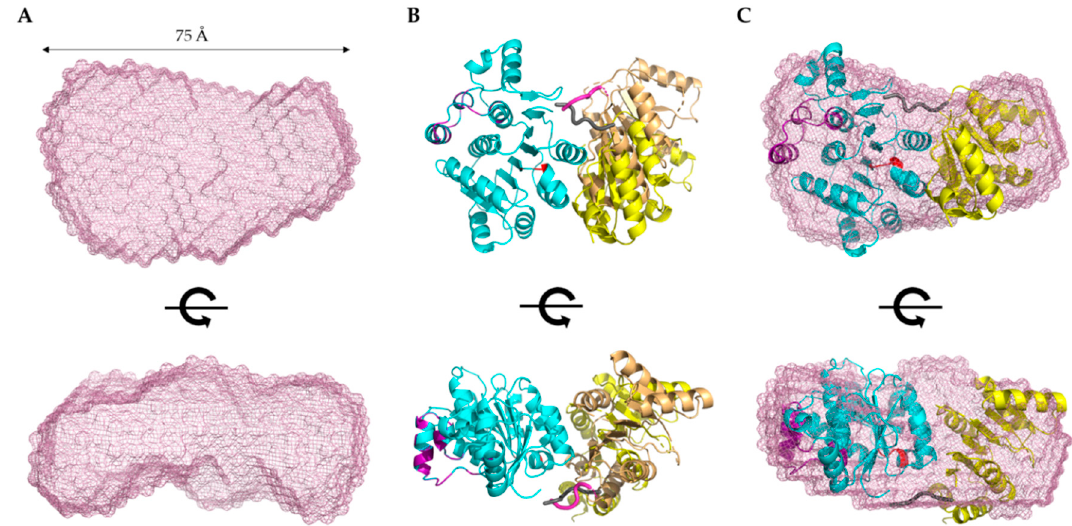
Figure 5. Structural modeling of DDX17 135–555 . ( A ) Low-resolution SAXS structure indicating that DDX17 135–555 adopts an extended globular conformation in solution. The bottom panel represents a 90° rotation of the x-axis from the top panel. Dimensions represent the D max from P(r) analysis. ( B ) CORAL-derived models of DDX17 135–555 , suggesting a linker (purple/gray chain) between the ATP-binding domain (blue ribbon), and the helicase domain (yellow/brown ribbon), allowing them to adopt different orientations. ( C ) SAXS envelope overlayed with the CORAL-derived representative model highlighting an agreement between high- and low-resolution models.